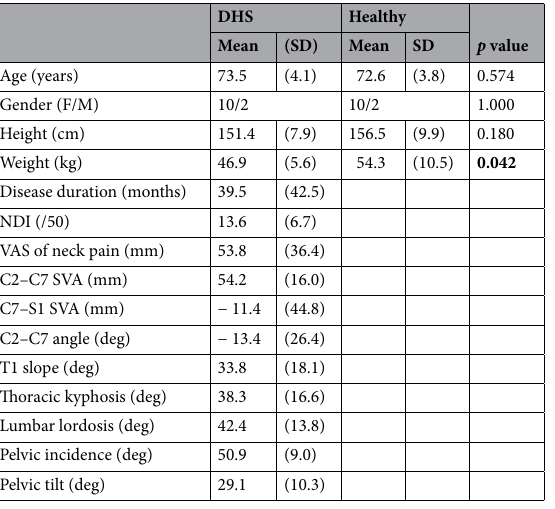
Table 1. Demographic data of the participants. Bold figures indicate statistically significant p < 0.05. DHS Dropped head syndrome, NDI neck disability index, VAS visual analogue scale, SVA sagittal vertical axis, deg degrees.